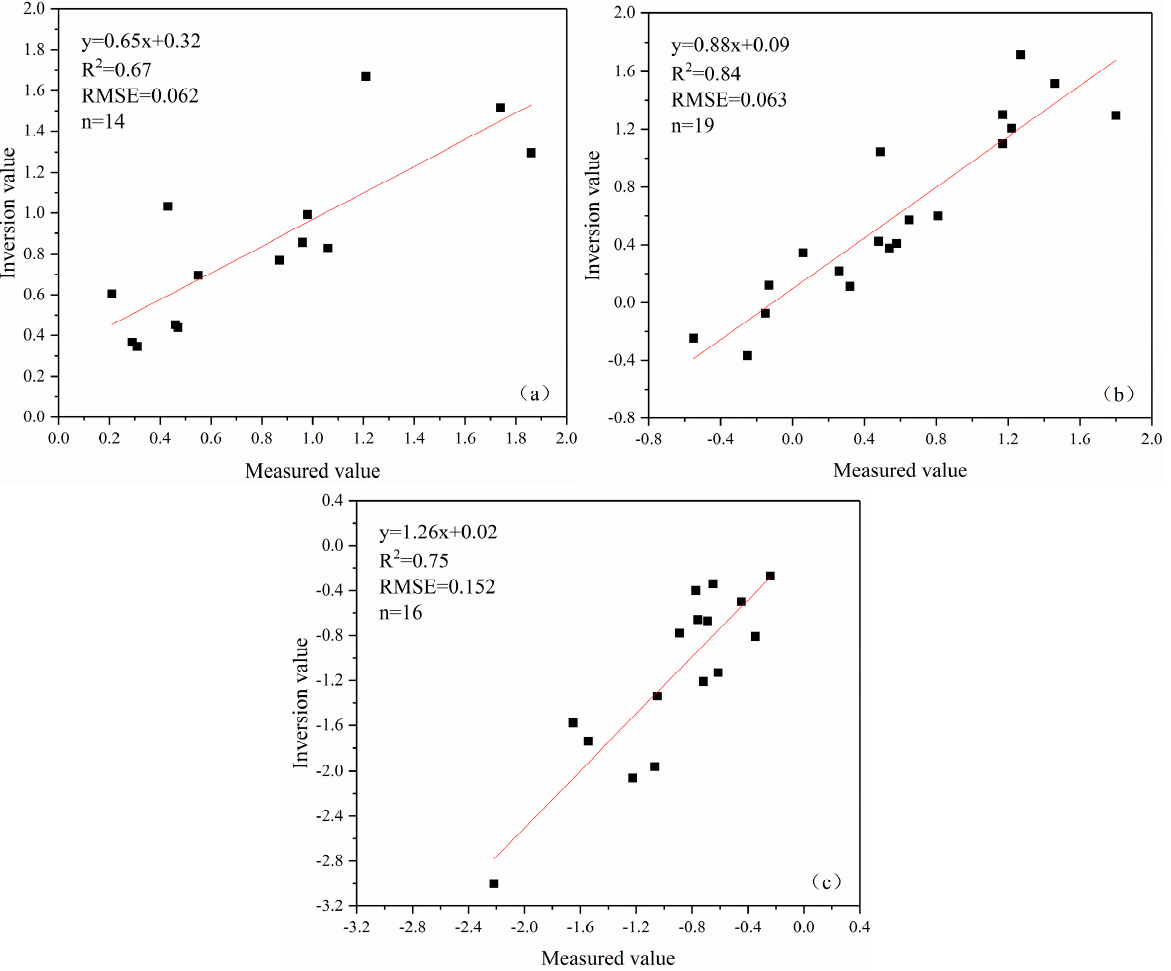
Figure 6. Scatter plots of the inverted and measured values of the east branch of No. 1 Glacier in the east ( a ), north ( b ) and vertical ( c ) directions (unit: m).